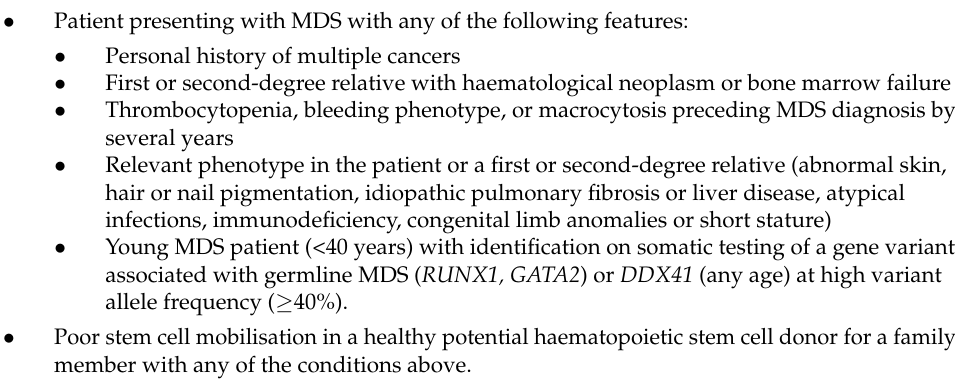
Table 2. Individuals in whom inherited predisposition to MDS must be considered, adapted WHO criteria